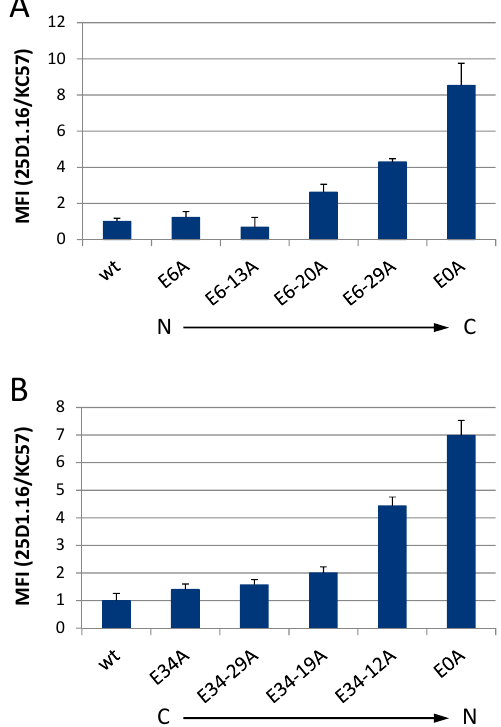
Figure 7. Successive mutation of the glutamic acids within p6 progressively increases the MHC-I antigen presentation of Gag-derived epitopes. HeLa-K b cells were transiently transfected with pNL env 1-SL expression plasmids coding for wt or the sequential Glu mutants of p6 from ( A ) the N- to the C-terminus or ( B ) the C- to the N-terminus, respectively. H2-K b -SL complexes presented on the surface of Gag-positive cells were quantified by flow cytometry using the mAb 25D1.16-APC [58]. After fixation and permeabilization, intracellular Gag was stained with anti -Gag Ab KC57-FITC. The mean fluorescence intensity (MFI) of the 25D1.16 staining, normalized to the MFI of the intracellular anti -Gag staining (see Figure S2) is shown. Bars represent mean values ± SD from three independent